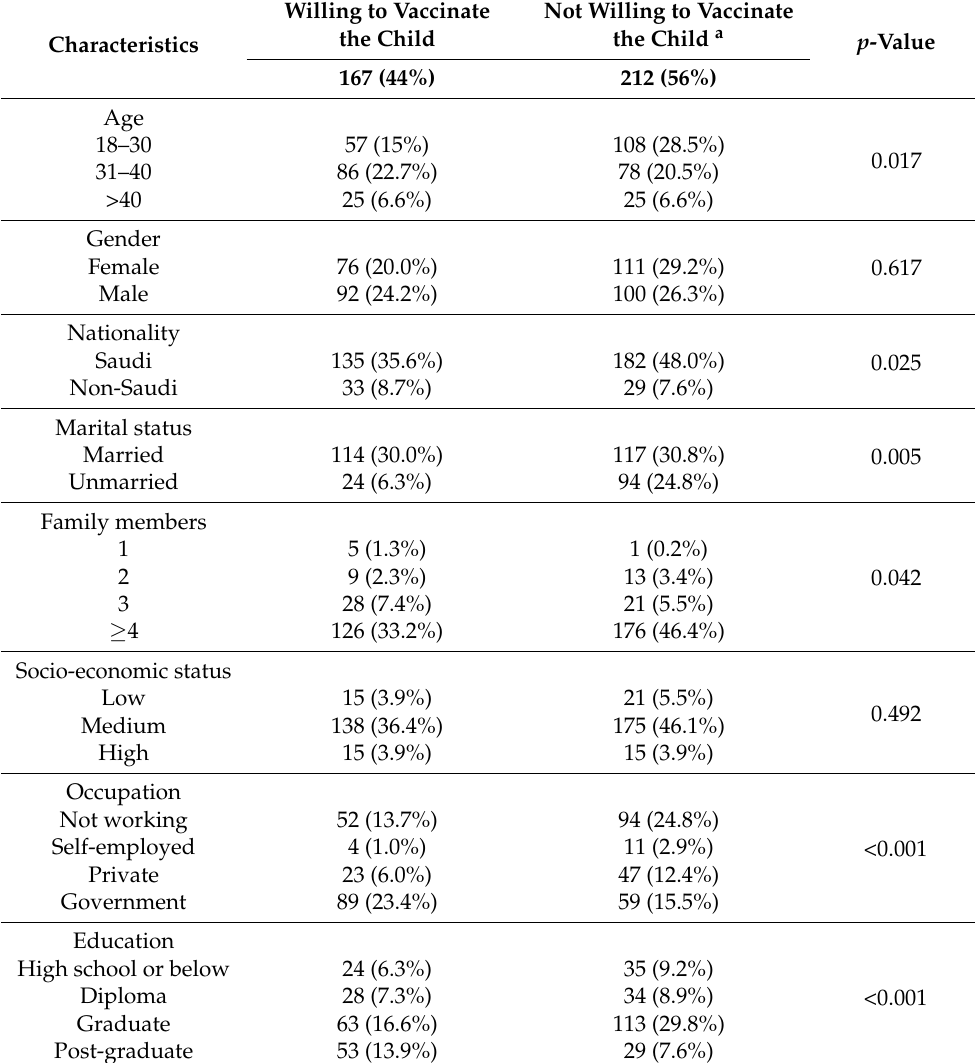
Table 2. Parental characteristics associated with the willingness to vaccinate their children with a COVID-19